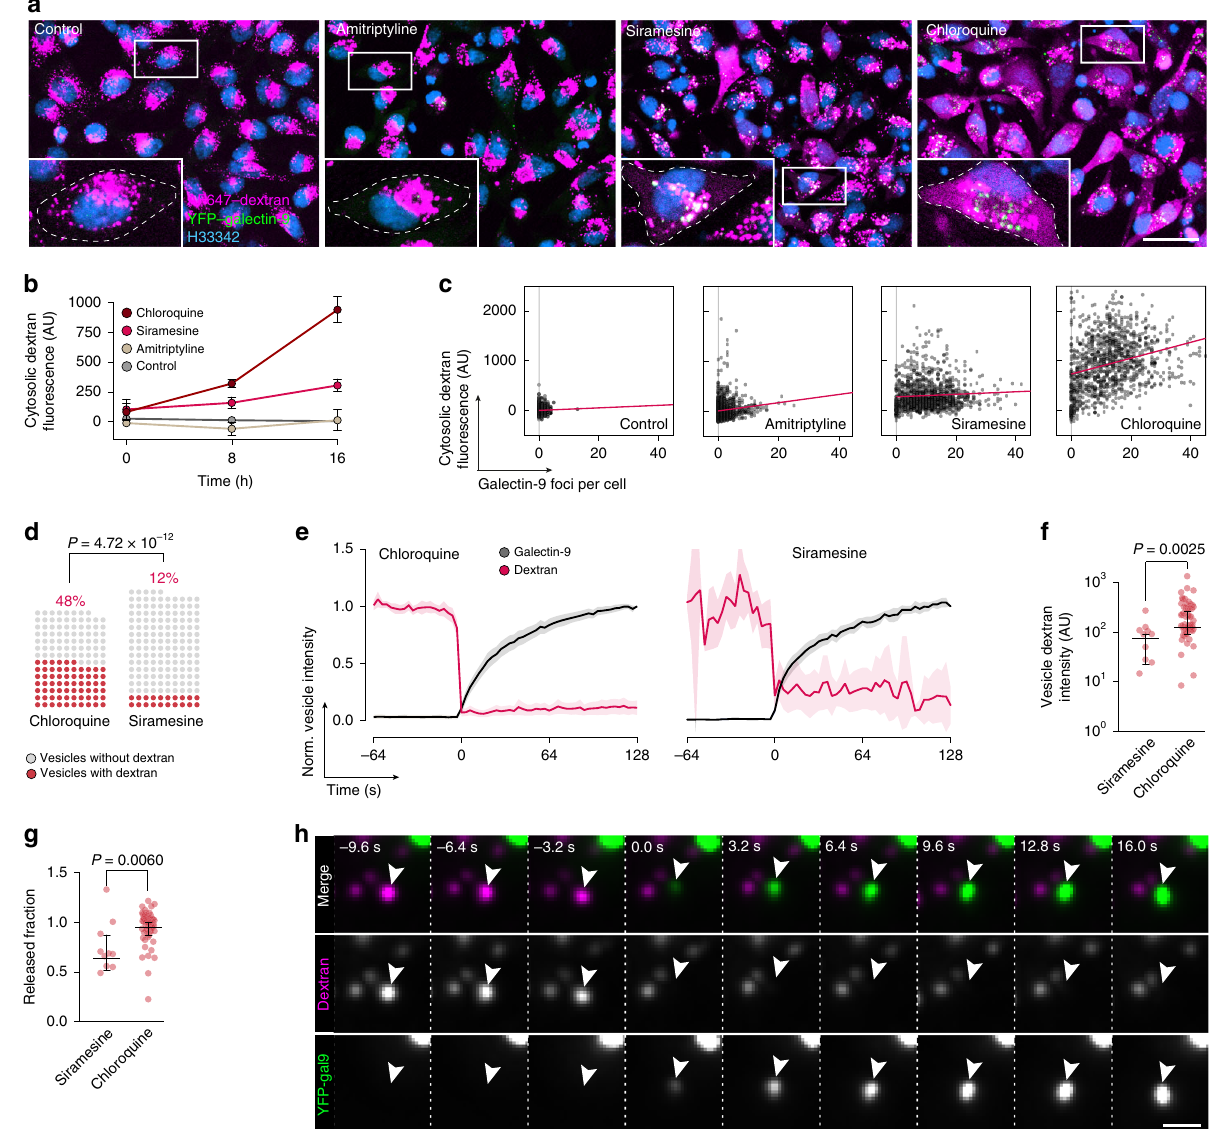
Fig. 4 Linking single-vesicle release and cytosolic dispersion of dextran. a Confocal microscopy images of HeLa cells expressing YFP – galectin-9 incubated with 200 μ g mL − 1 AF647-dextran for 4 h followed by 2 h chase, and treated with 10 μ M siramesine, 60 μ M amitriptyline, or 60 μ M chloroquine for 16 h. Images are representative details from three independent experiments. Scale bar, 40 μ m. b Quanti fi cation of cytosolic dextran fl uorescence intensity from confocal microscopy images in a . Mean± s.d. from three independent experiments. c Number of galectin-9 foci and median cytosolic dextran fl uorescence intensity per cell after 16 h drug treatment. Three independent experiments. N = 953, 1204, 1177, and 1139 cells. Red line is linear regression. d – h Live-cell wide fi eld microscopy was used to monitor HeLa cells expressing YFP – galectin-9 incubated with AF647-dextran for 4 h, followed by 2 h chase before treatment with 60 μ M chloroquine or 10 μ M siramesine. d Fraction of damaged endosomes containing dextran before galectin-9 recruitment. N = 138 and 165 vesicles from two independent experiments. Two-tailed Fisher ’ s exact test. e Single-vesicle tracking was used to quantify dextran release from damaged endosomes. Lines are means, shades are 95% CI. Traces are aligned so that galectin recruitment is fi rst detected at t = 0. N = 54 and 10 vesicles from two independent experiments. f Dextran fl uorescence intensities of releasing endosomes measured ∼ 15 s before detectable galectin-9 recruitment, and g fraction of dextran released from single endosomes calculated from vesicle intensities ∼ 15 s before and ∼ 45 s after detectable galectin-9 recruitment. Median ± interquartile range. N = 10 and 54 vesicles from two independent experiments. Two-tailed Mann – Whitney test. h Arrows indicate release of dextran from an endosome showing galectin-9 recruitment during chloroquine treatment. Images are representative of 66 release events from two independent experiments. t = 0 is the fi rst frame with detectable galectin recruitment. Scale bar, 2 μ m. Source data for b – g are presented in a Source Data fi